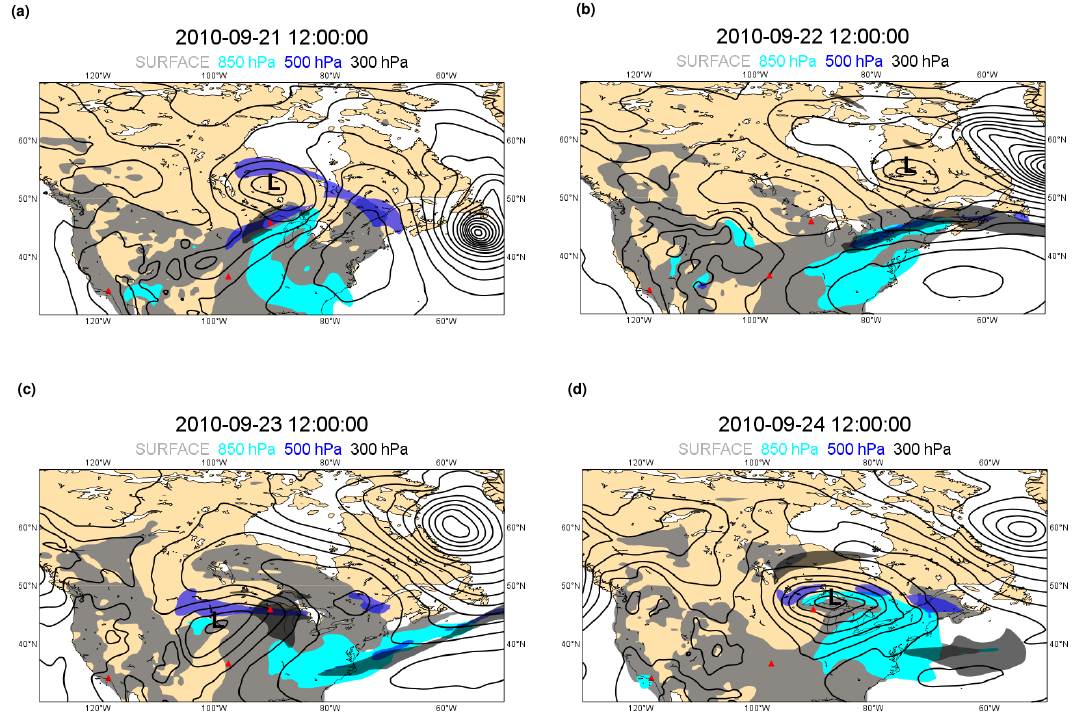
Figure 9. Transport of atmospheric CO 2 anomalies associated with the passage of low pressure systems over North America. The colours depict the CO 2 anomalies anomalies above the well-mixed background CO 2 at different vertical levels: grey near the surface, cyan at 850hPa, blue at 500hPa and dark grey at 300hPa. The anomalies are defined as CO 2 dry molar fraction above the background value of 392ppm for both near the surface and at the 850hPa level; and above the background value of 388ppm for the 500 and 300hPa levels. The location of the TCCON sites are depicted by a red triangle. The black contours of mean sea level pressure show the location of the centre of the low pressure systems